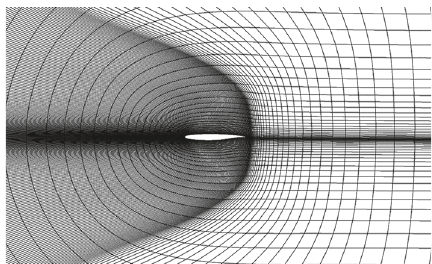
Figure 9: Far-field of Euler mesh optimized with curvature control functions but without orthogonality functions, showing the impact of curvature functions when compared to Figure 7(a).